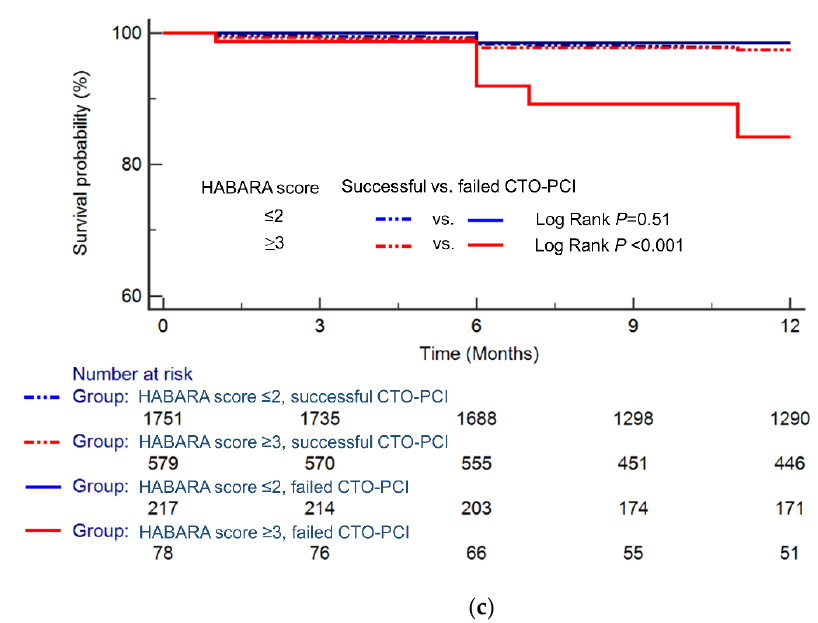
Figure 3. Survival curves after CTO-PCI: ( a ) survival curves after CTO-PCI stratified by procedural results, ( b ) survival curves after CTO-PCI stratified by HABARA score, ( c ) survival curves after CTO-PCI stratified by the HABARA score grade among patients with successful and failed CTO-PCI. Abbreviations: CTO, chronic total occlusion; HABARA, how aggressively the successful result of CTO-PCI should be achieved by the operator; PCI, percutaneous coronary intervention.